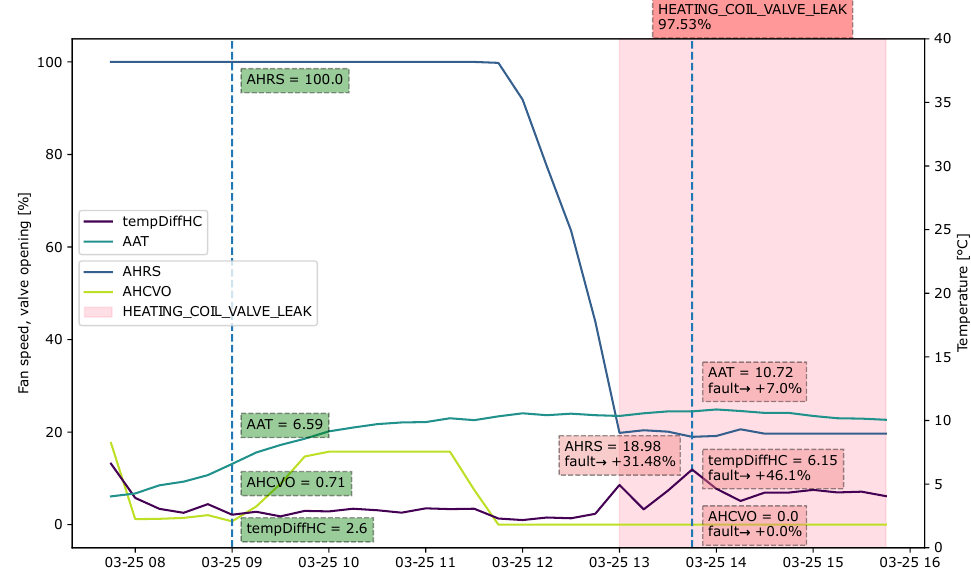
Figure 12. Explanation visualized as a sliding window for the fault type “Heating coil valve leak” during an observation period from 08:00 to 16:00.